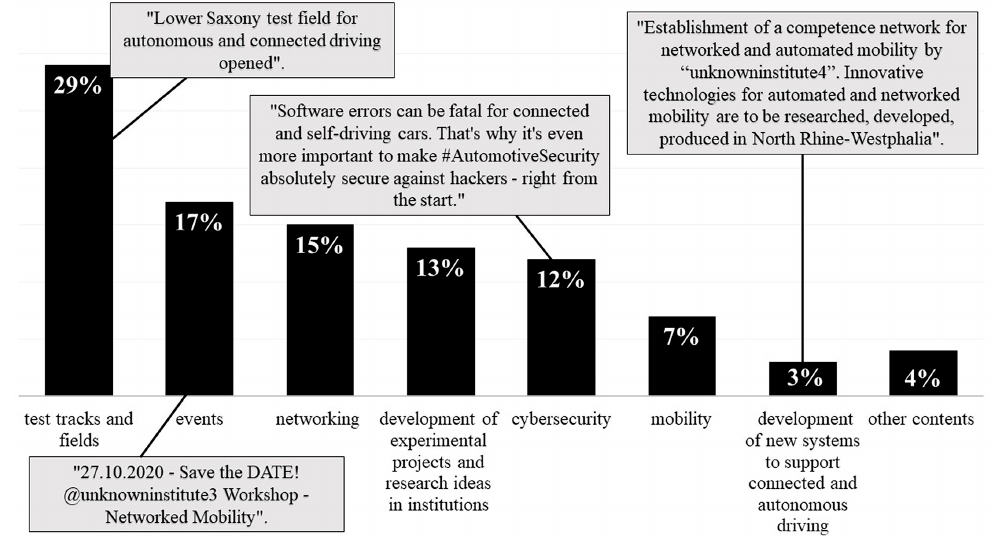
Figure 7. Topic distribution and example tweets in the category CC+AD: News/Information.